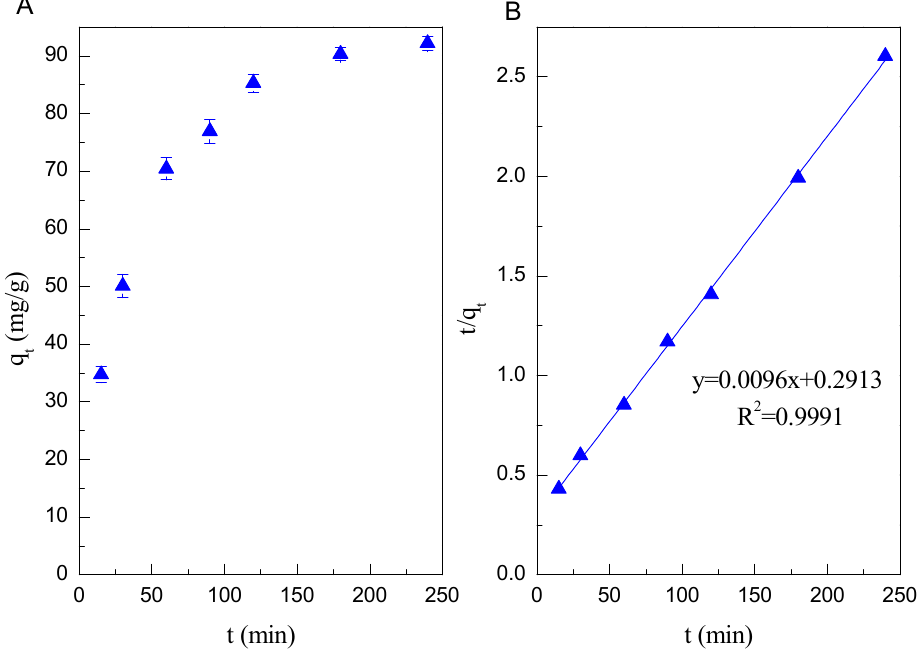
Figure 2. ( A ) The adsorption kinetics of Cd(II) on Mn oxide (pH = 6, C = 100 mg/L, I = 0.01 mol/L NaClO 4 , m / v = 1 g/L, T = 298 K); ( B ) Pseudo second ‐ order kinetic plot. NaClO 4 , m / v = 1 g/L, T = 298 K); ( B ) Pseudo second-order kinetic plot.